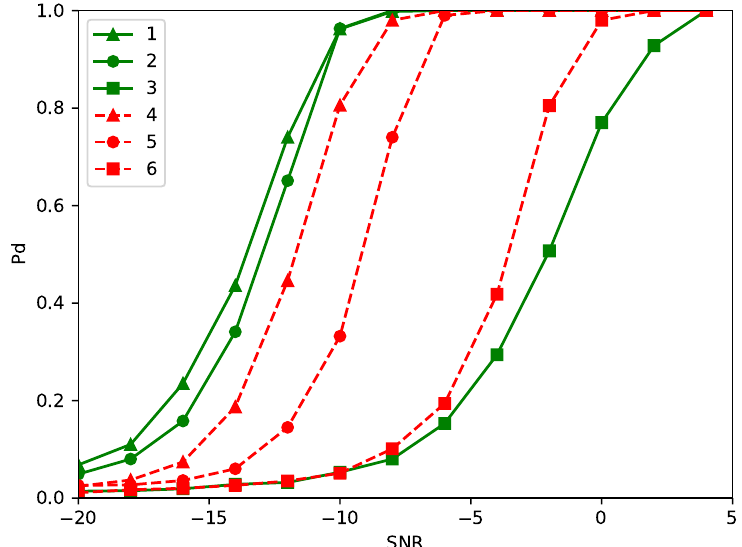
Figure 5. The P d corresponding to the six data augmentation methods.